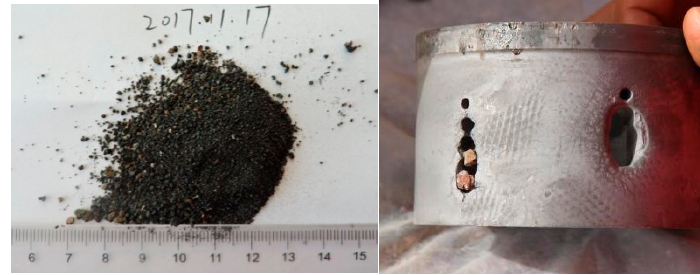
Figure 2. Sand sample and erosion diagram of nozzle cage.